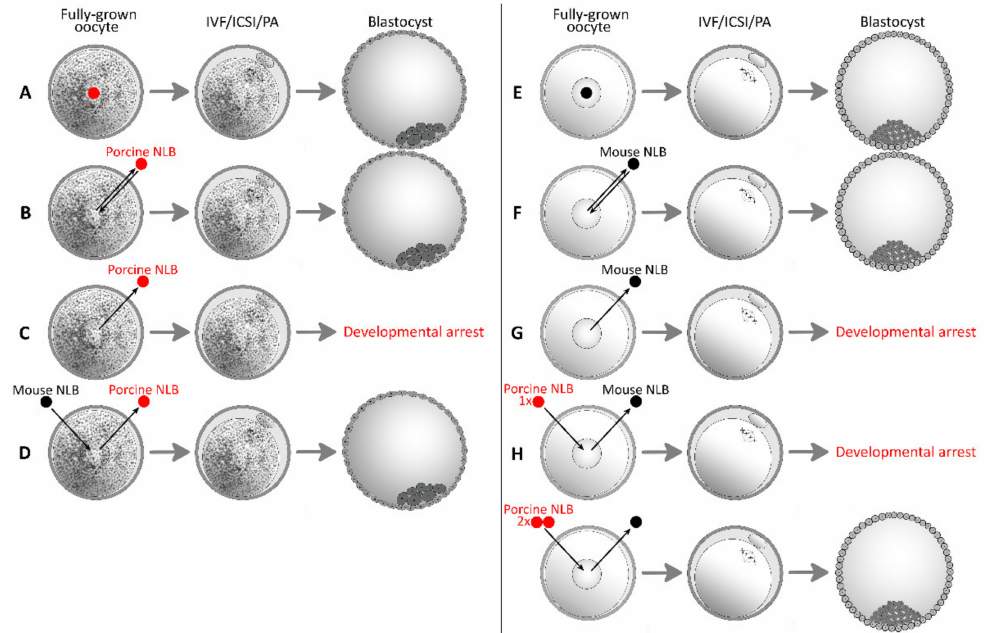
Figure 1. Intraspecies and interspecies nucleolus-like body (NLB) transfer. (IVF/ICSI/PA) In vitro fertilization, intracyto- plasmic sperm injection, parthenogenetic activation; ( A – D ) porcine oocytes, blastocyst; ( E – H ) mouse oocytes, blastocyst; ( A , E ) intact group; ( B , F ) enucleolated and intraspecies re-injected oocytes develop to the blastocyst stage [13]; ( C , G ) embryos from previously enucleolated oocytes arrest before genome activation, porcine embryos usually at the 4-cell stage ( C ), mouse embryos usually at the 2-cell stage ( G ) [13]; ( D , H ) an NLB from a different species is able to support the embryonic development of an embryo from a previously enucleolated oocyte, but the amount of NLB material is essential. Significant differences in protein content were observed [30,35]. Two porcine NLBs are able to replace one mouse NLB. If one mouse NLB is replaced with one porcine NLB, embryonic development fails [33,34].